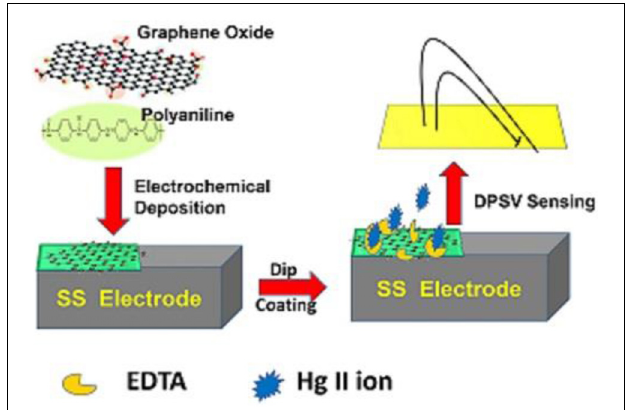
FIGURE 1 | Schematic diagram of the formation of EDTA_PANI/GO modified composite on an SS electrode for the detection of Hg (II) ions by the DPSV technique.